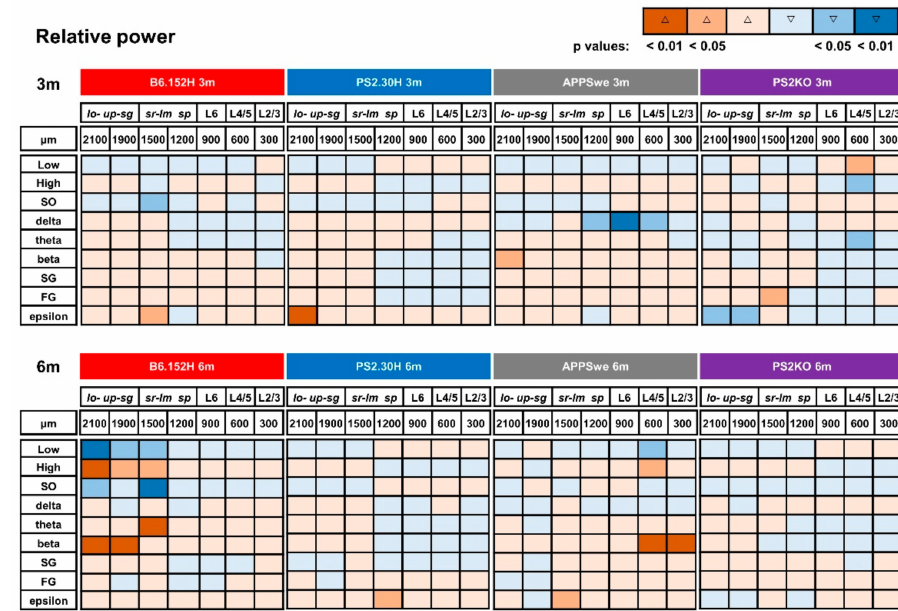
Figure 4. Age-matched genotype comparison of changes in the relative band powers. Synoptic view of the changes occurring in the relative band powers at the di ff erent depths of three- (upper panel) and six- (lower panel) month-old tg mice with respect to age-matched WT mice. Changes are color-coded in terms of increase ( ∆ ) or decrease ( (cid:53) ) and statistical